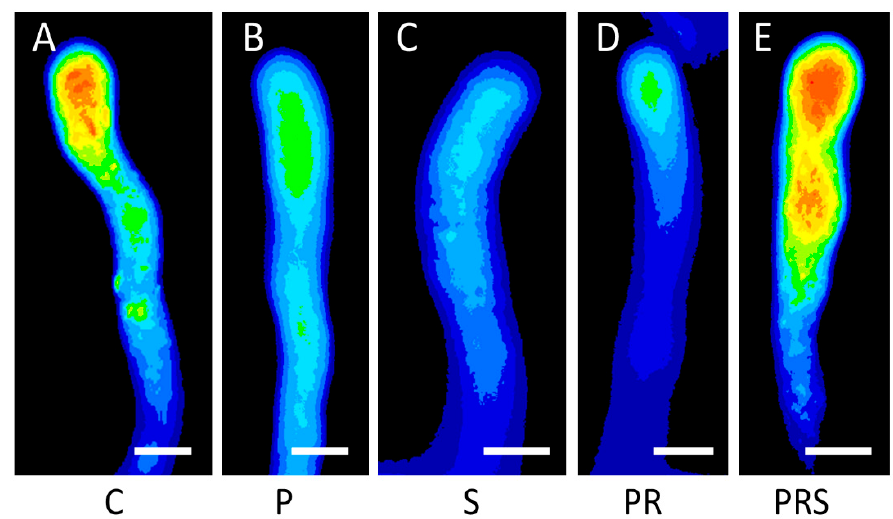
Figure 9. Analysis of reactive oxygen species (ROS) distribution in pollen tubes: ( A ) control sample (C); ( B ) primed sample (P); ( C ) stressed sample (S); ( D ) primed and recovered sample (PR); ( E ) primed, recovered and stressed sample (PRS). Figure reports the most representative images. At least 30 pollen grains and tubes were analyzed. Bars 10 μ m.